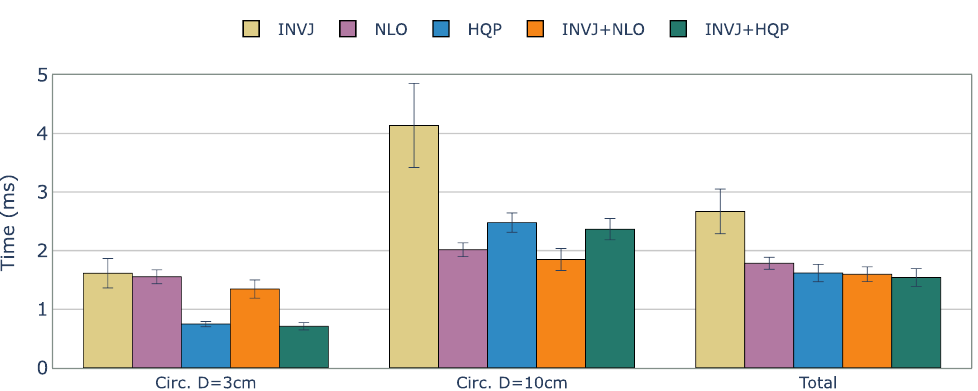
Figure 9. Average runtime (ms) of successful IK solves for a constrained tracking task with KC- 3 (Hyper-redundant RST) kinematic chain. The concurrent solvers demonstrated slightly better performance than their respective optimization-based single-method IK solvers, with INVJ+HQP showing the best average solving time